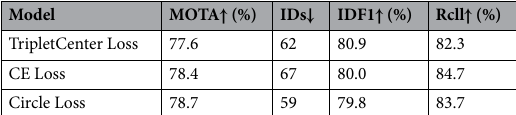
Table 2. Impact of different loss functions.